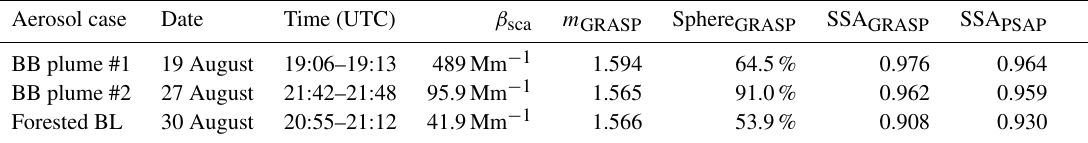
Table 2. Truncation-corrected total scattering ( β sca ) from the integrating nephelometer as well as the GRASP retrieval of real refractive index, sphere fraction and SSA for the three highlighted case studies. Additionally, the SSA derived from PSAP and integrating nephelometer measurements is shown for comparison. All spectrally dependent parameters are listed at